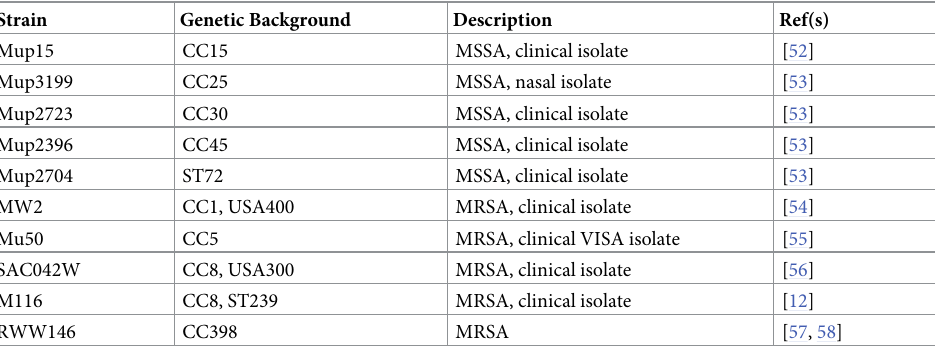
Table 1. Strains of S . aureus used.